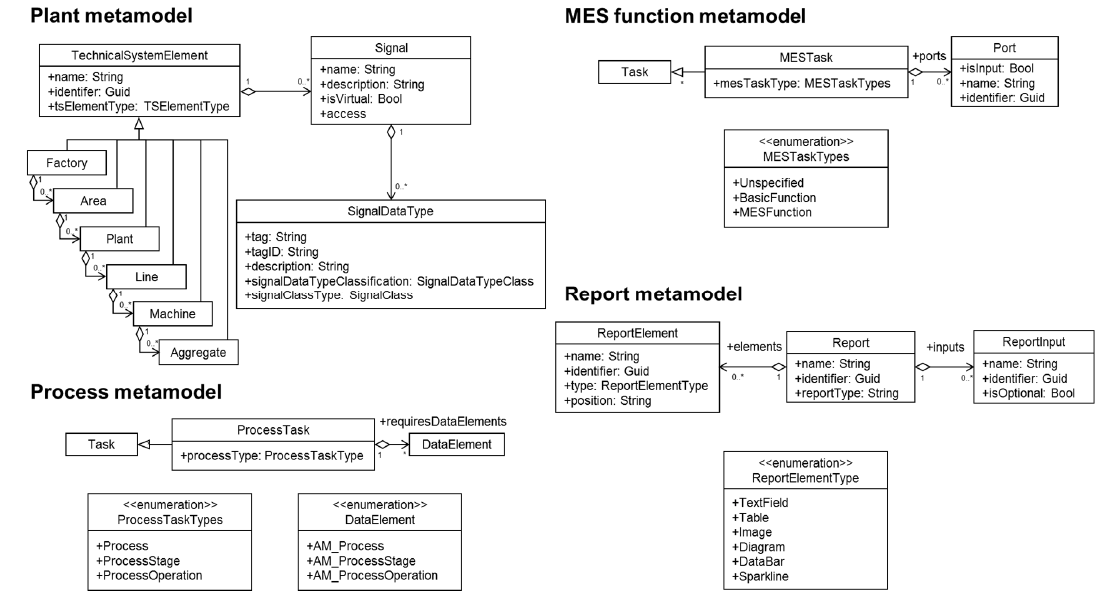
Figure 3. Metamodel of the modeling language MES Modeling Language (MES-ML) [57,59].